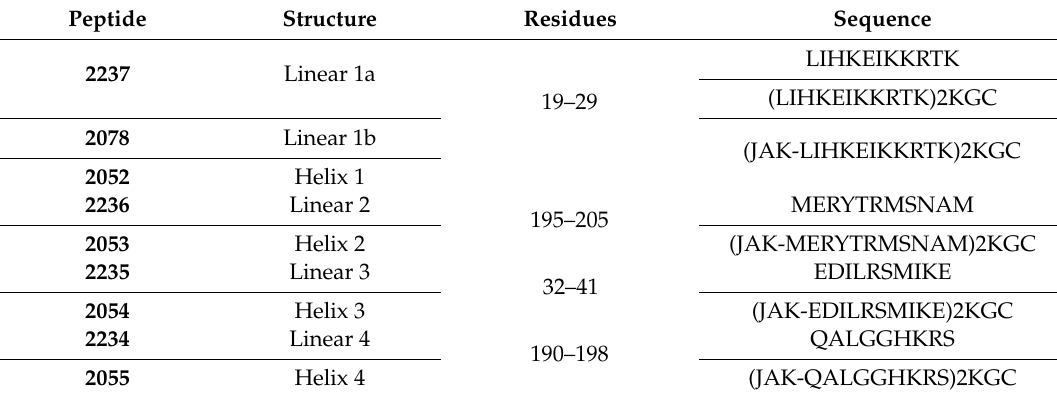
Table 4. Synthesized